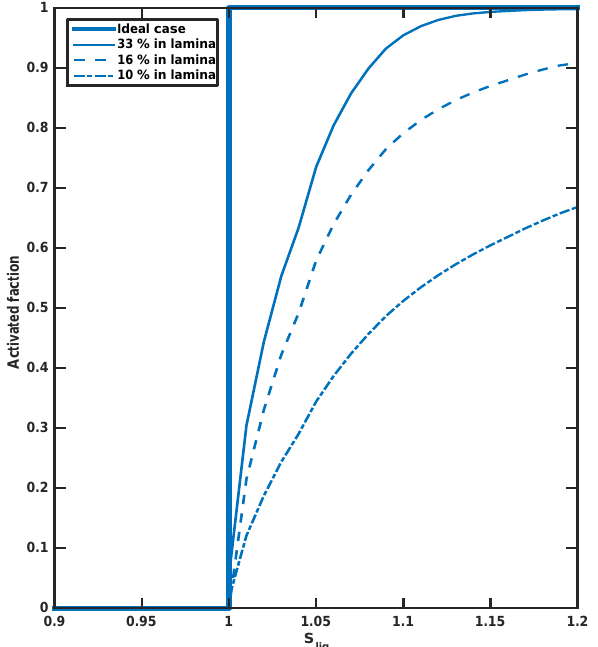
Figure 8. Fraction of particles that activate as a function of satura- tion with respect to liquid water. All particles are assumed to be per- fect immersion INPs which activate as ice crystals when exposed to water saturation ( S liq = 1). In the ideal case, where all particles are constrained within the lamina ( f lam 100%; all particles exist within the dash-dotted lines in Fig. 2), all nucleation occurs at a CFDC saturation of S liq = 1 (bold solid line). The other three curves cor- respond to increasingly less ideal behavior (i.e., increasingly fewer particles in the lamina and existing farther from the centerline), cor- responding to f lam falling from 33 to 10%. In these cases an in- creasingly higher maximum CFDC saturation is required so that the particles farthest from the centerline experience S liq = 1.